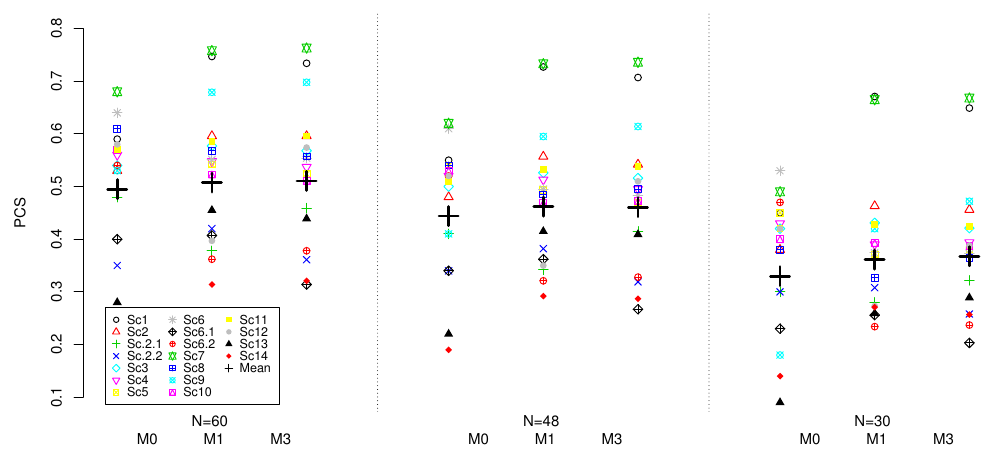
Figure 1. PCS for M0, M1 and M3 models under 18 scenarios and the sample sizes of N = 60,48,30. Results are based on 4000